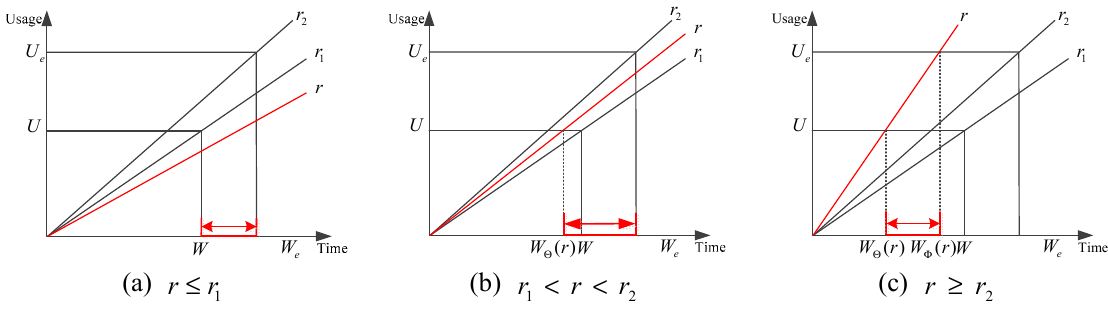
r r > . Figure 4. Schematic diagram of EW period when r > r 2 1 2 1